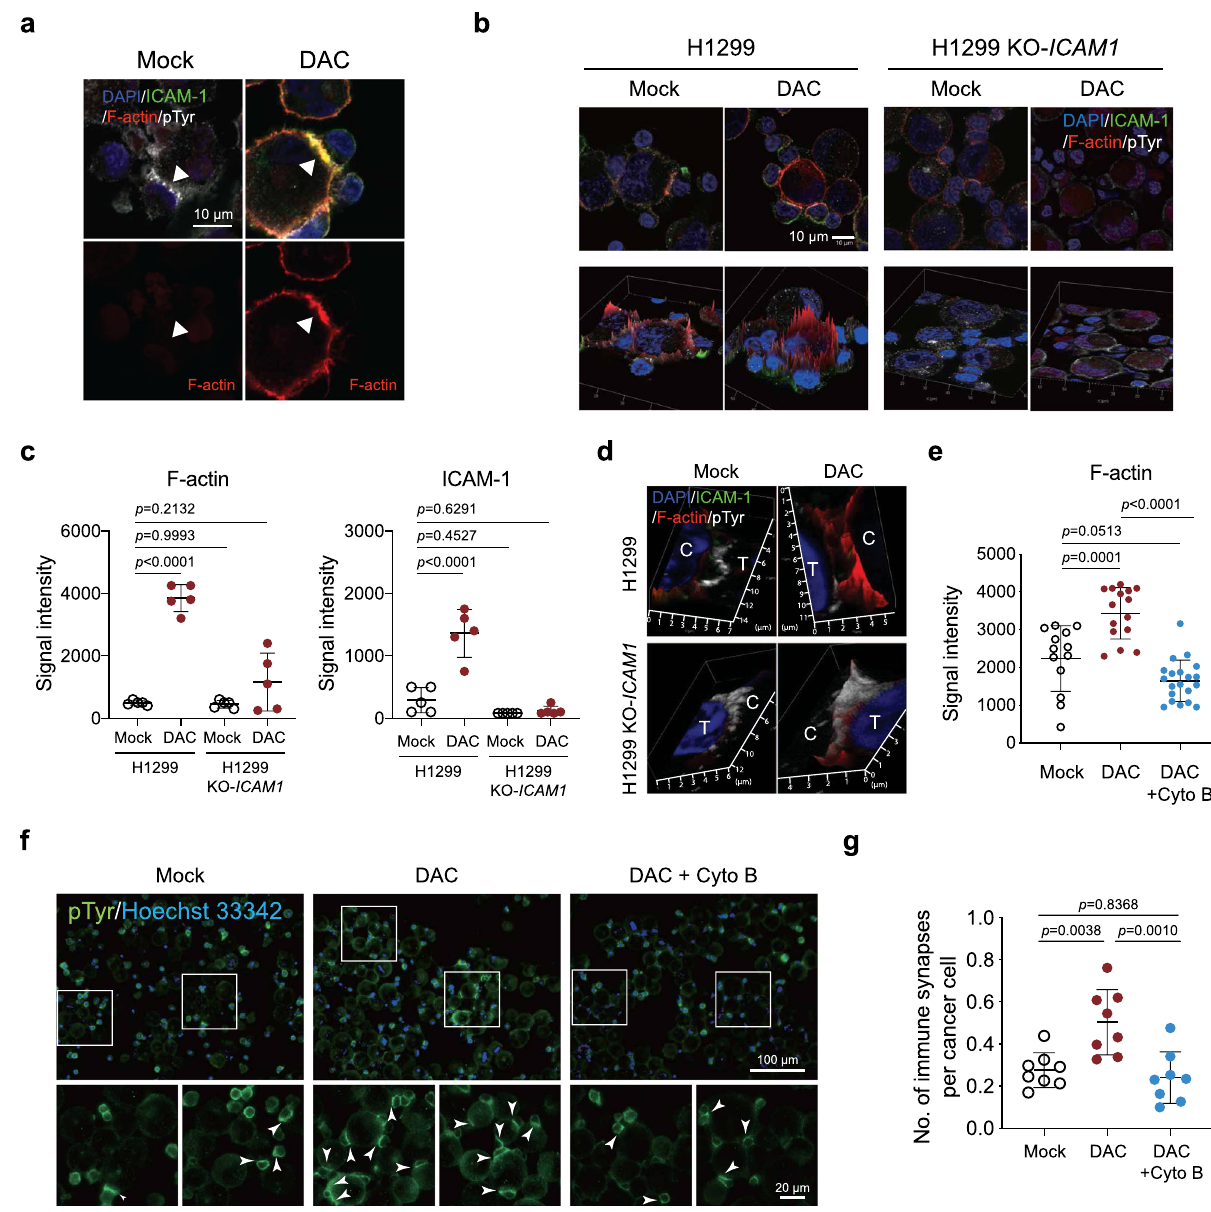
Fig. 4 Decitabine stabilizes the immune synaptic cleft by strengthening the actin cytoskeleton. a Immuno fl uorescence staining of F-actin (red), ICAM-1 (green), pTyr (phosphotyrosine, white) at immune synapses between γδ T cells and DAC-pretreated H1299 lung cancer cells at D3R3. DAPI: 4 ′ ,6- diamidino-2-phenylindole. Scale bar: 10 μ m. Three independent experiments were performed. b Immuno fl uorescence images of the interfaces between γδ T cells and H1299 lung cancer cells (parental vs. ICAM1 knockout (KO- ICAM1 )). Signals of F-actin (red) in the periphery of H1299 cancer cells are shown in two-and-a-half-dimensional (2.5D) images in the lower panels. Scale bar: 10 μ m. Three independent experiments were performed. c Dot plots of signal intensities of F-actin and ICAM-1 from fi ve pTry-positive immune synapses between γδ T cells and H1299 lung cancer cells (parental or KO- ICAM1 ) from three independent experiments (mean ± SD). d Immuno fl uorescence images of immune synapses between γδ T cells (marked with T) and H1299 lung cancer cells (marked with C) stained for ICAM-1, F-actin, and pTyr. Three independent experiments were performed. e Dot plots of F-actin signal intensities at immune synapses between γδ T cells and H1299 cells. H1299 cells are pretreated with PBS (Mock), DAC alone or a combination of DAC pretreatment (D3R3) and 1 μ g/mL Cyto B (cytochalasin B) for 1.5 h before coculture with γδ T cells (mean ± SD). n = 13 – 20 immune synapses over three independent experiments. f Immuno fl uorescence images of immune synapses between γδ T and H1299 cells pretreated with PBS (Mock), DAC alone, and combination of DAC and Cyto B. Blow-up images of the square areas for each treatment are shown in the lower panels. Arrows denote immune synapses between γδ T and H1299 cells. Scale bar: 100 μ m (upper) and 20 μ m (lower panels). Two independent experiments were performed. g Dot plots showing numbers of immune synapses per cancer cell on eight randomly taken high power fi elds for H1299 cells pretreated with PBS (Mock), DAC, and combination of DAC and Cyto B (mean ± SD). The p value is calculated by the two-way ANOVA ( c ) or one-way ANOVA with Tukey ’ s multiple comparisons test ( e , g